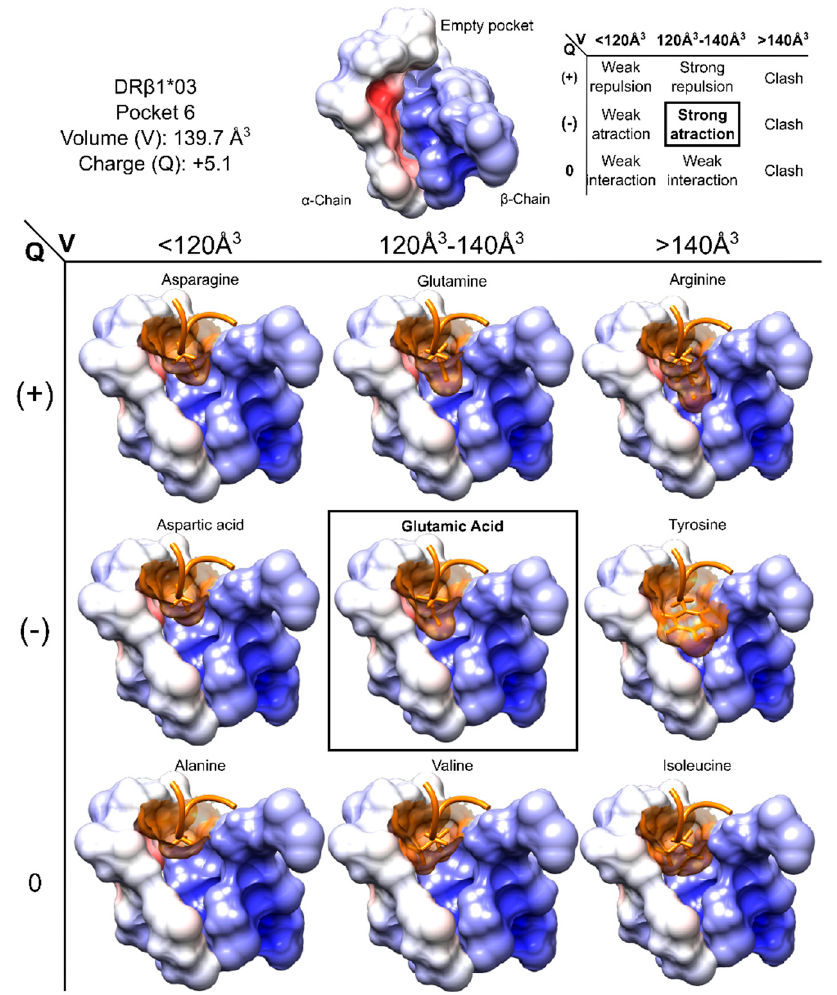
Figure 4. Pocket volume and charge showing aa having different volumes and charge fitting into HLA-DR β 1*03 P6. Pocket characteristics and interactions are summarised at the top of the Figure, while the surface structures of aa occupying P6 are shown at the bottom. P6 surface is coloured according to its electrostatic potential set from − 3 kT/e (negatively charged, red) to 3 kT/e (positively charged, blue). Figure based and adapted from [187]. Reproduced with permission from Patarroyo ME, Biochem. Biophys. Res. Commun. ; published by Elsevier, 2017.